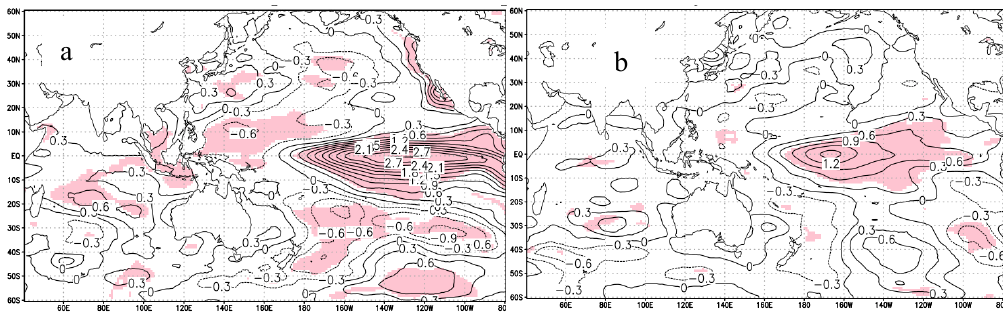
Figure 4. Composite SST anomalies (units: °C) during DJF 1980–2017 for ( a ) autumn and ( b ) winter El Niño events. The contour interval is 0.3 °C. Only values significant at the 95% level have been shaded, based on the Student’s t -test.